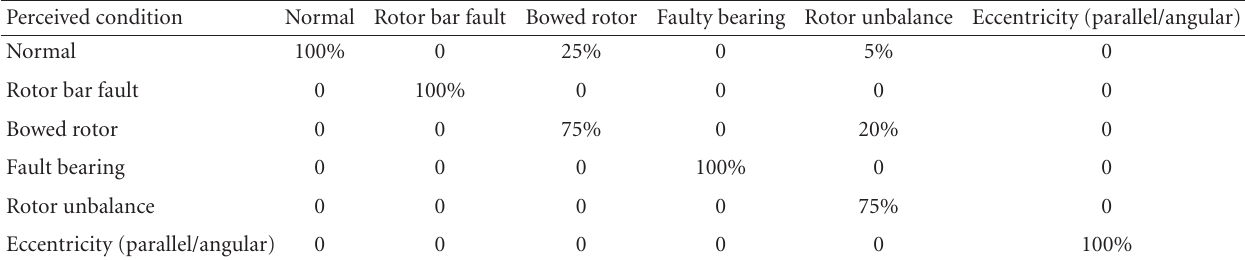
Table 7: Success rate under no-load condition using only time-domain features ( ρ = 0 . 900).